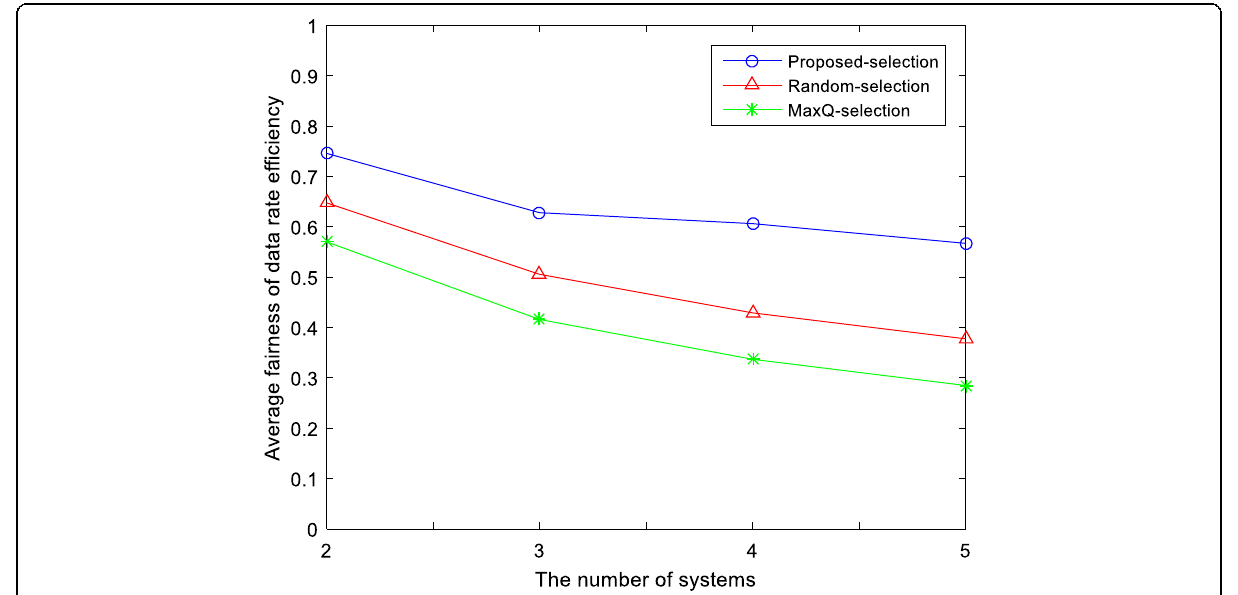
Fig. 21 The average fairness of data rate efficiency with increasing number of neighboring secondary